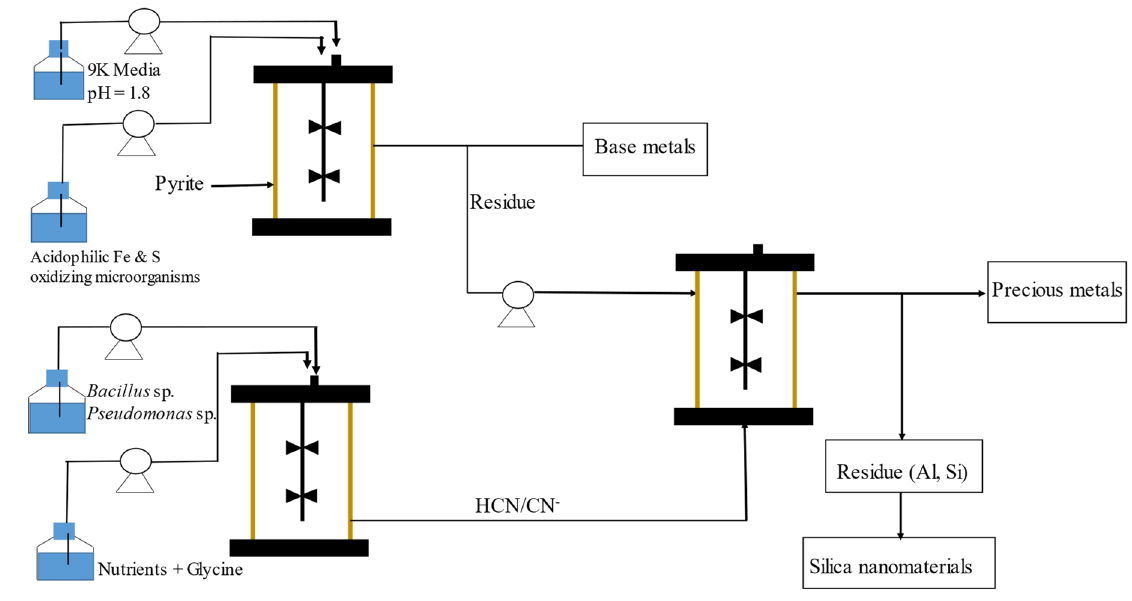
Figure 2. Proposed metal extraction process from electronic waste.